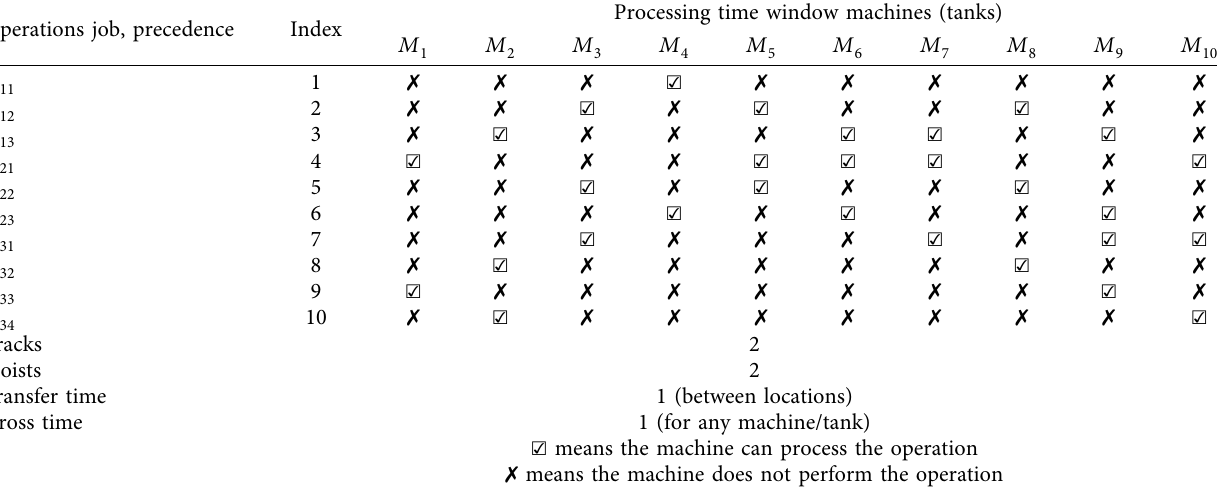
Table 5: Scenario and data for the MHEDA.